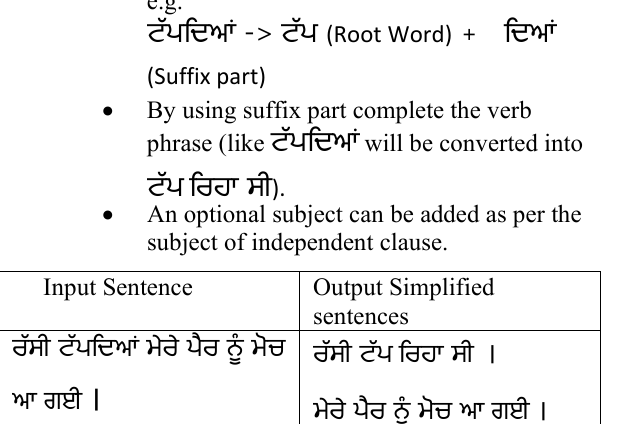
Conversion of dependent clause into independent